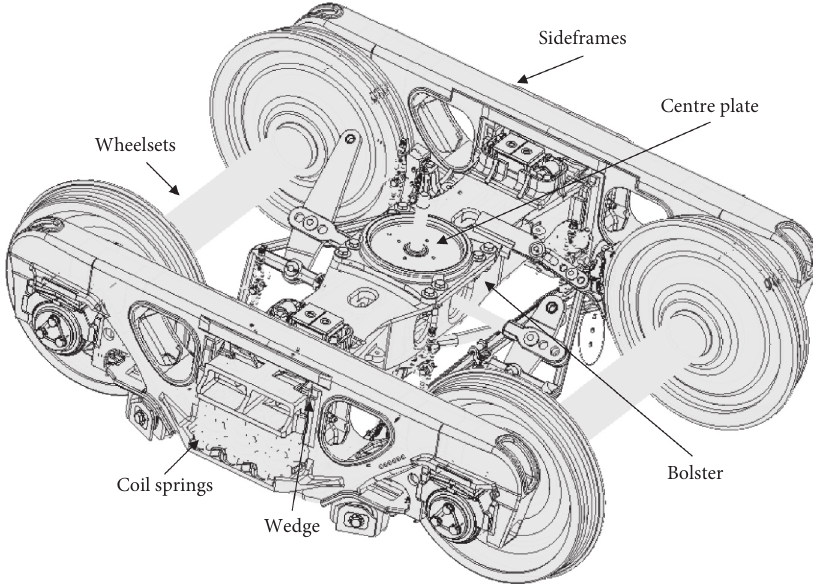
Figure 1: Bogie structure.